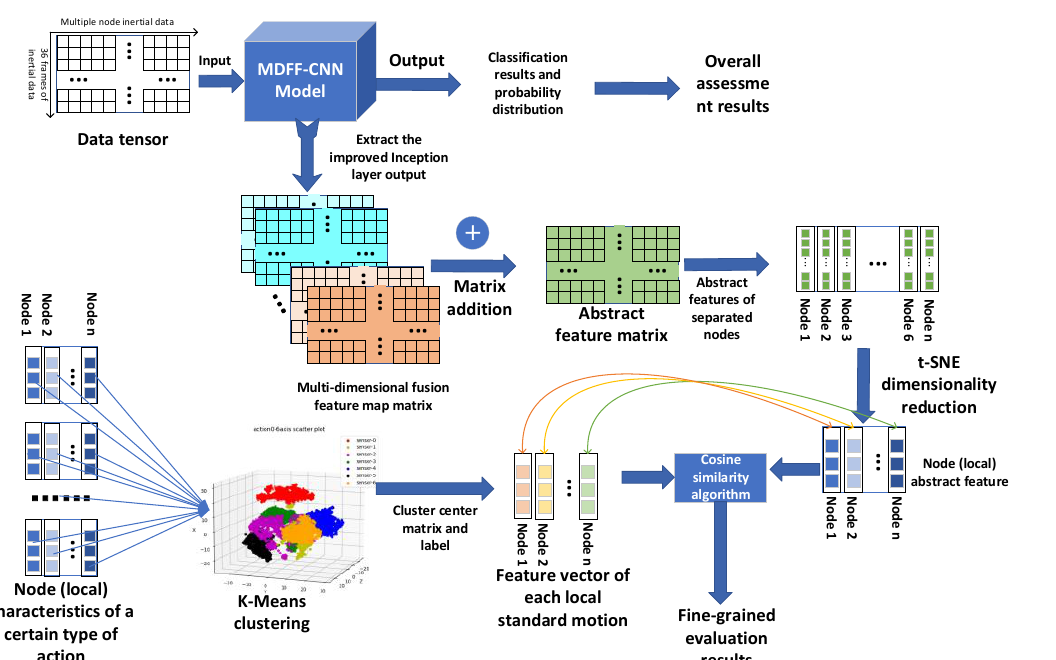
Figure 8. Schematic diagram of table tennis action evaluation algorithm.